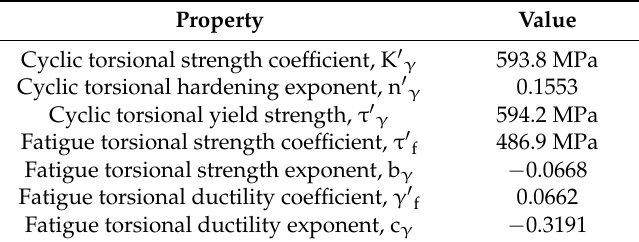
Table 4. Torsional properties of S355-J2G3 steel.